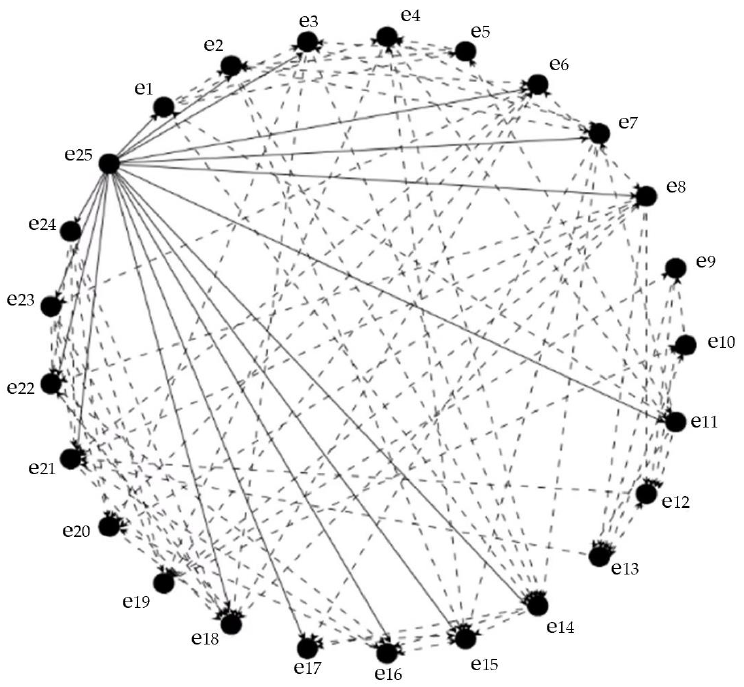
Figure 3. Community emergency management index pyramid network analysis structure chart.